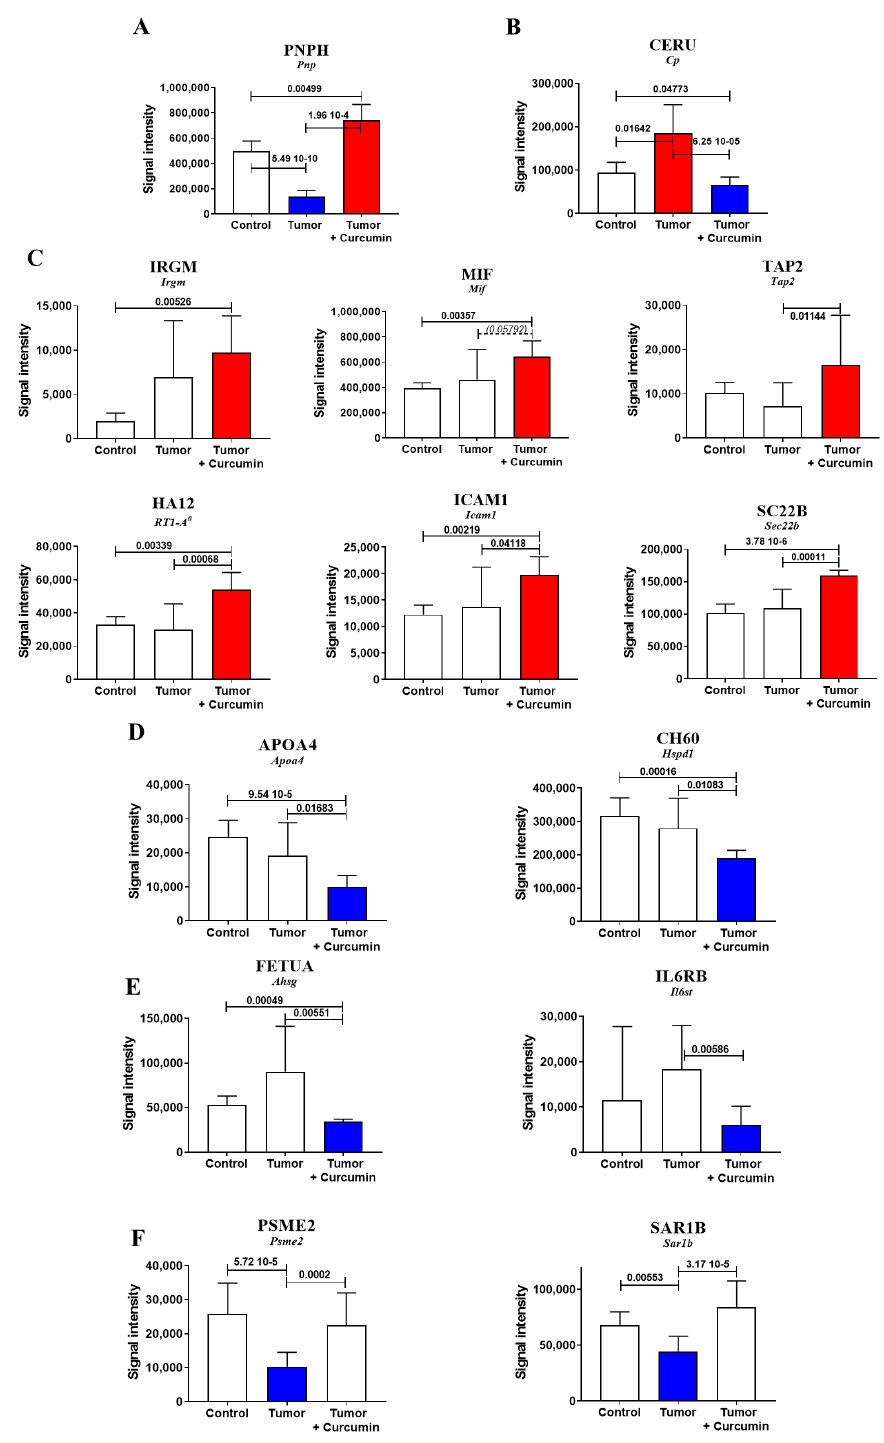
Figure 2. Biomarkers associated with the curcumin-induced immune response. Comparison of protein abundances between the three groups of rats, revealing different patterns of changes (significant increases in red and decreases in blue, with p -values indicated above the bars). Blank bars correspond to the absence of significant differences between groups. The names of genes coding for the proteins are indicated in italics below each protein abbreviation. ( A ), ( B ) differential evolution of protein abundances in treated (G3) and untreated rats (G2) relative to normal rats (G1). ( C ) Increased abundance in G3 (relative to G1 and/or G2). ( D ) Decreased abundance in G3 (relative to G1 and G2). ( E ) Decreased abundance in G3 (relative to G2). ( F ) Decrease in G2 vs. G1 and G2 vs. G3. 2.3. Biomarkers Specifically Related to Metastatic Colonization of the Liver by M5-T1 Cells For this purpose, the two files of proteins exhibiting abundance changes ( n = 439 for G2 vs. G1 and n = 549 for G2 vs. G3) were cross-compared, and then all proteins appearing significantly changed in the third list ( n = 355 for G3 vs. G1) were excluded (Figure 3A). This led to a final list of 179 proteins, 61 presenting a common decrease and 118 showing a common increase in G2 vs. G1 and G2 vs. G3 while unchanged in G3 vs. G1. The proteins with the largest decreases are illustrated in Figure 3B (for NCPR (NADPH-cytochrome P450 reductase) located in the endoplasmic reticulum), Figure 3C (for CALM (Calmodulin) located in the cytoplasm and cytoskeleton), and 3D (for AATM (Aspartate aminotransferase, mitochondrial), ADT2 (ADP/ATP translocase 2), DECR 2, 4-dienoyl-CoA reductase,